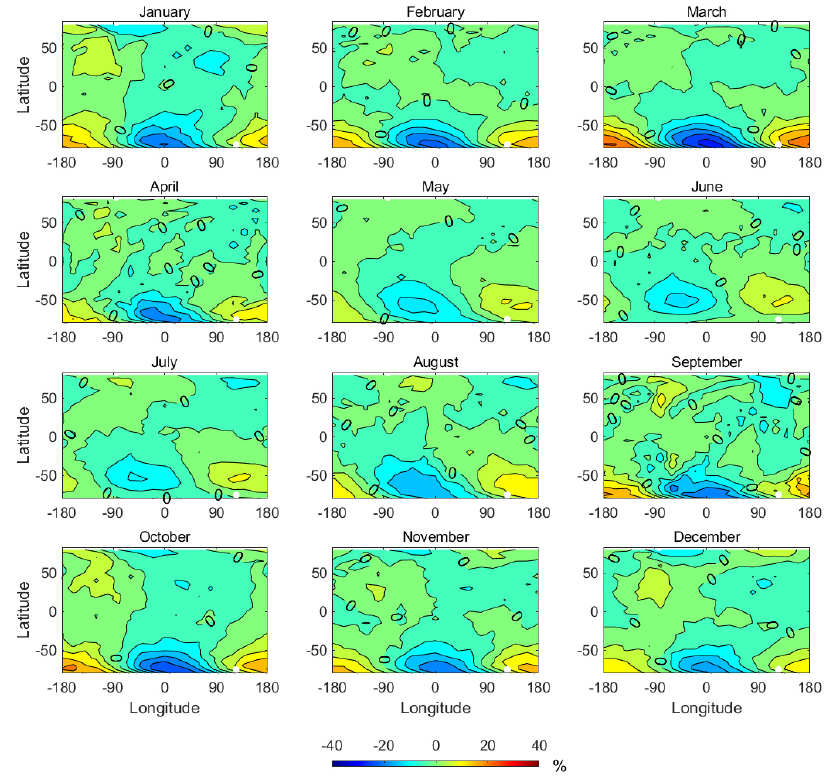
Figure 10. Same as Figure 6, except for the atmospheric number density.